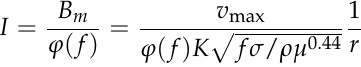
Table 5. Geometric parameters of studied